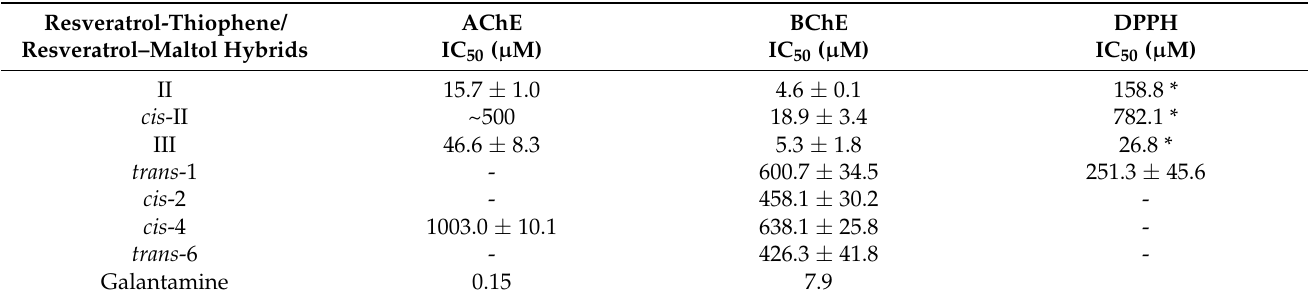
Table 1. ChE inhibitory effects and antioxidant activities for resveratrol–thiophene and the active resveratrol–maltol